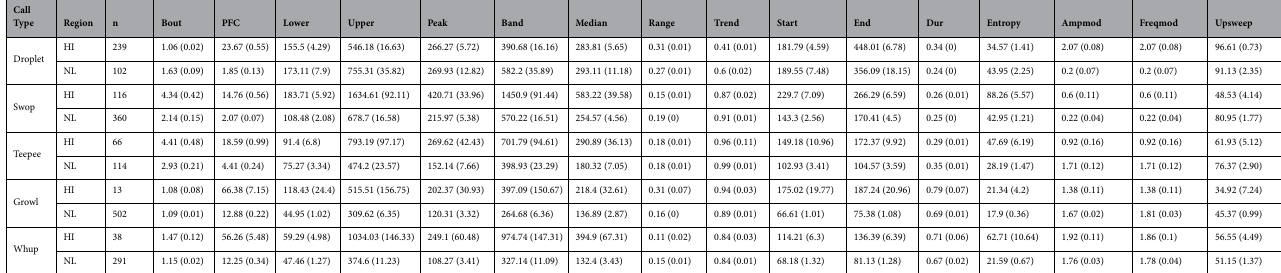
Table 2. Mean (SE) for each call type from both regions (Newfoundland—NL, Hawaii—HI) with sample sizes (n). Variable abbreviations correspond to those in Table 4.